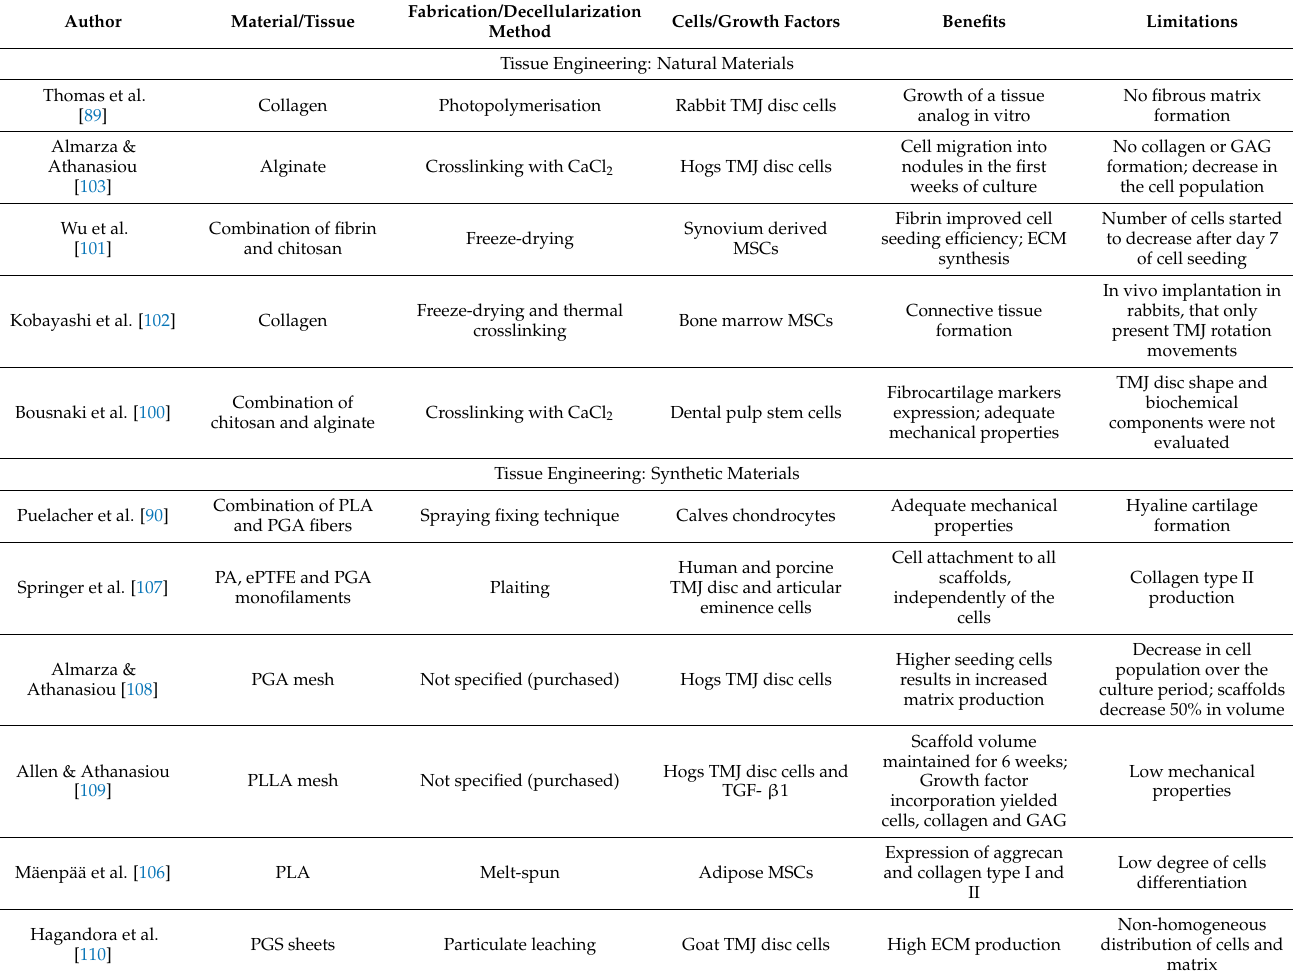
Table 2. Natural and synthetic materials used for tissue engineering of the TMJ